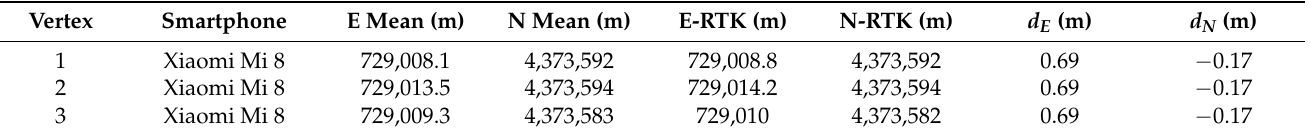
Table 12. Vertices 1, 2, and 3: East, North coordinates obtained from expression (27), East, North coordinates from real-time GNSS techniques (E-RTK, N-RTK) and the differences between ( d E , d N ). Vertex